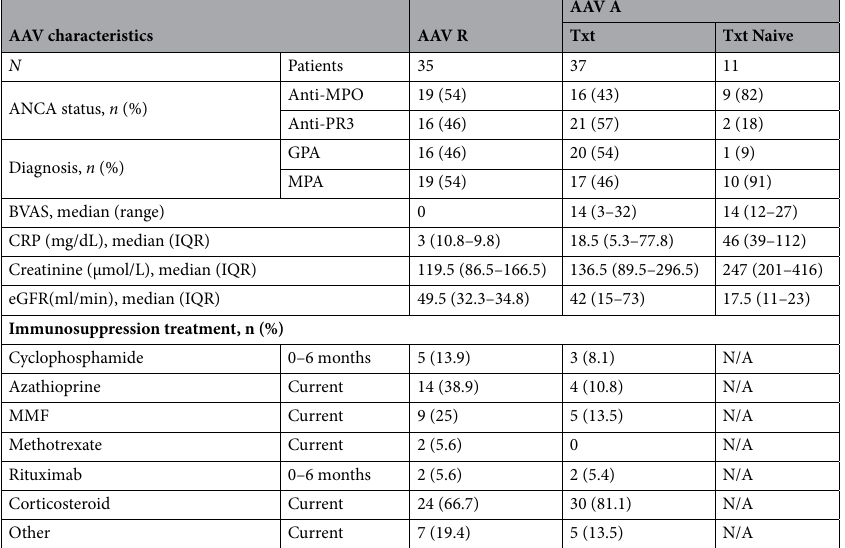
Table 2. AAV Characteristics: AAV participants have been divided into AAV R and AAV A cohorts with a further delineation of AAV A into treated (Txt) and treatment naïve (Txt Naïve) participants. A summary of clinical characteristics including ANCA status, diagnosis, Birmingham Vasculitis Activity Score (BVAS), C-reactive protein (CRP) cytokine levels, creatinine, estimated Glomerular Filtration Rate (eGFR) and treatment history is shown. IQR; interquartile